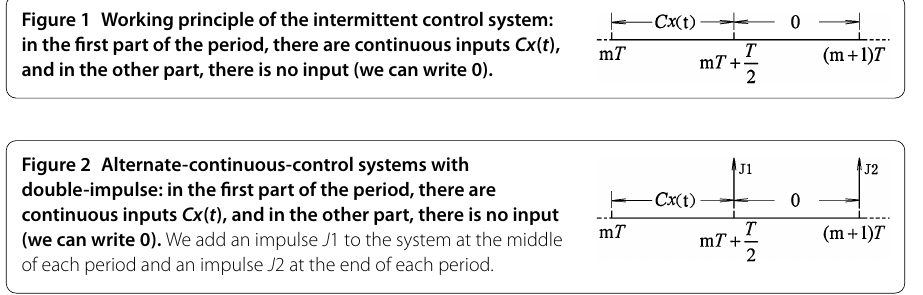
Figure 1 Working principle of the intermittent control system: in the first part of the period, there are continuous inputs Cx ( t ), and in the other part, there is no input (we can write 0).